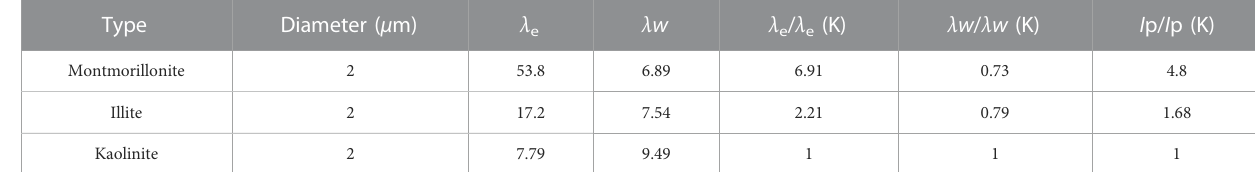
TABLE 2 CRFW and I p of three types of mineral particles ( d = 2 μ